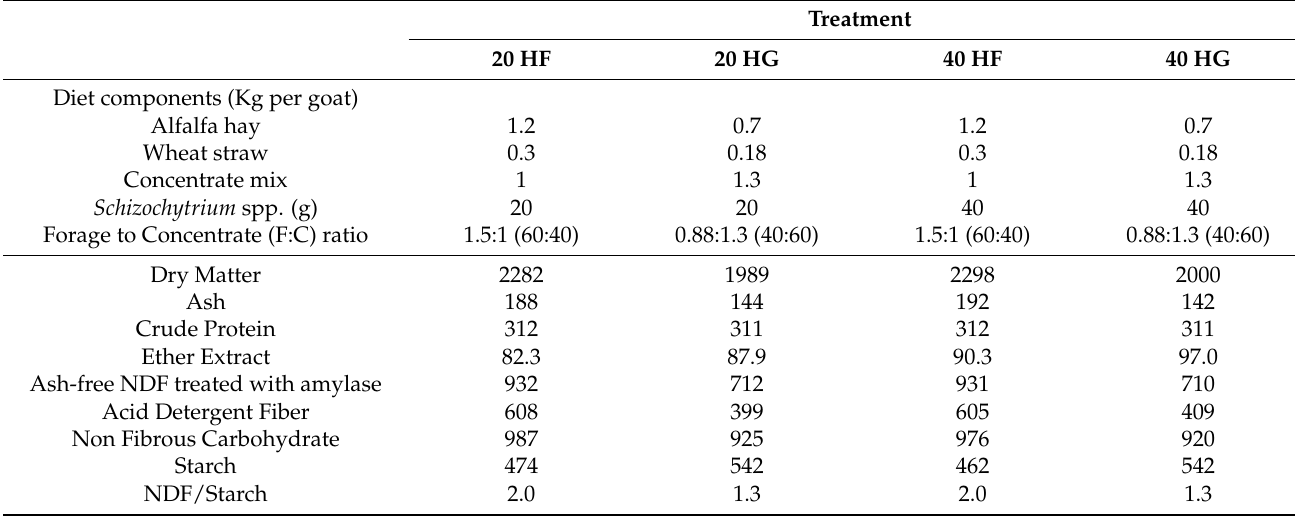
Table 1. Ration components (Kg/goat/day) and chemical composition (g/day) of the diets were administered to the four groups (20 HF, 20 HG, 40 HF, and 40 HG) of goats involved in the